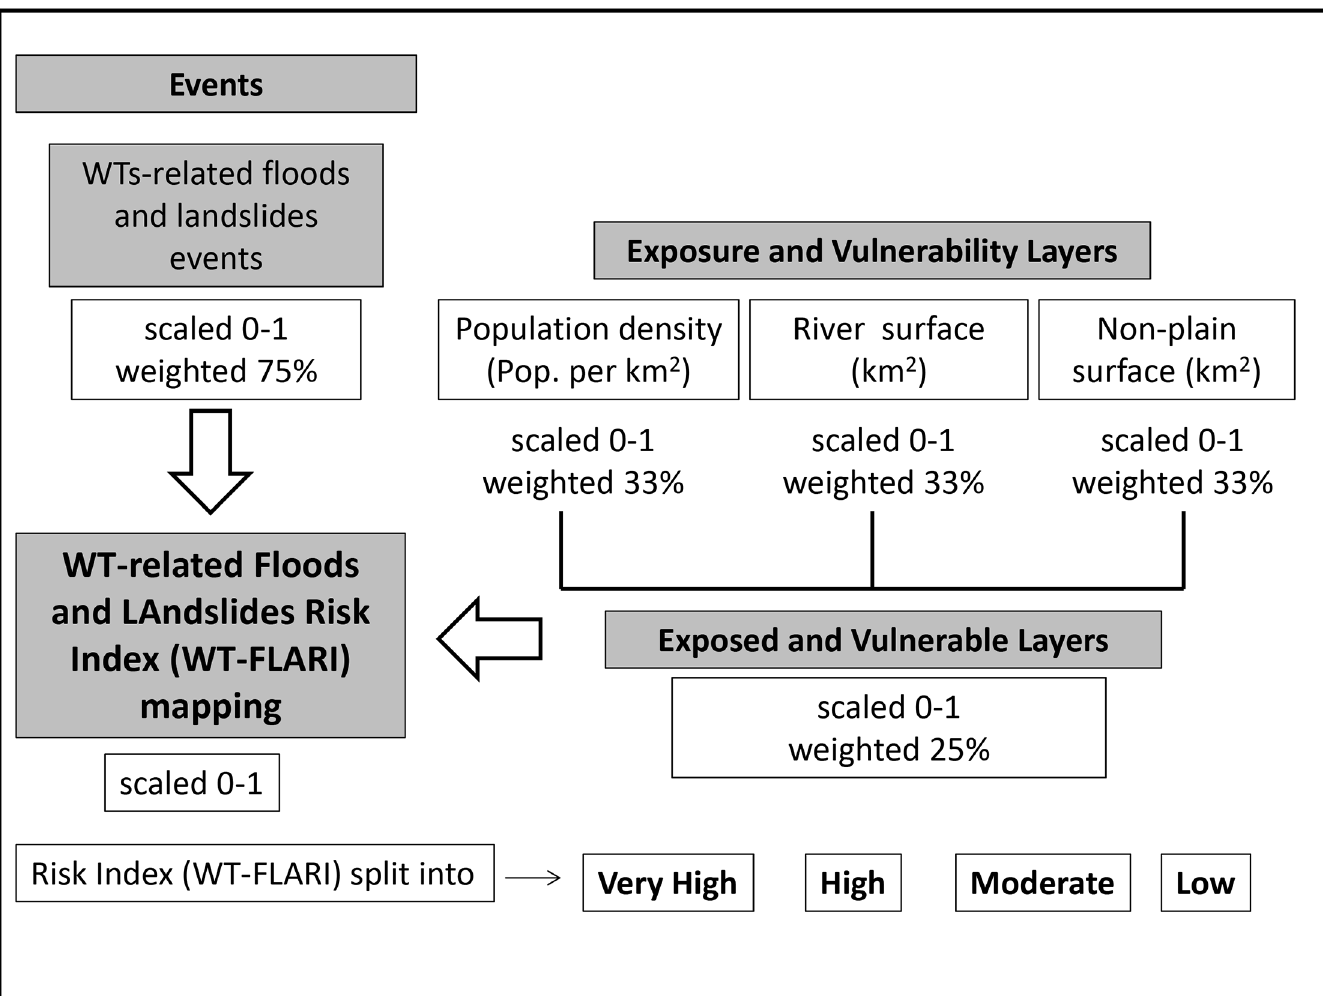
Fig 2. Work-flow of the Weather Type-related Floods and Landslides Risk Index (WT-FLARI)